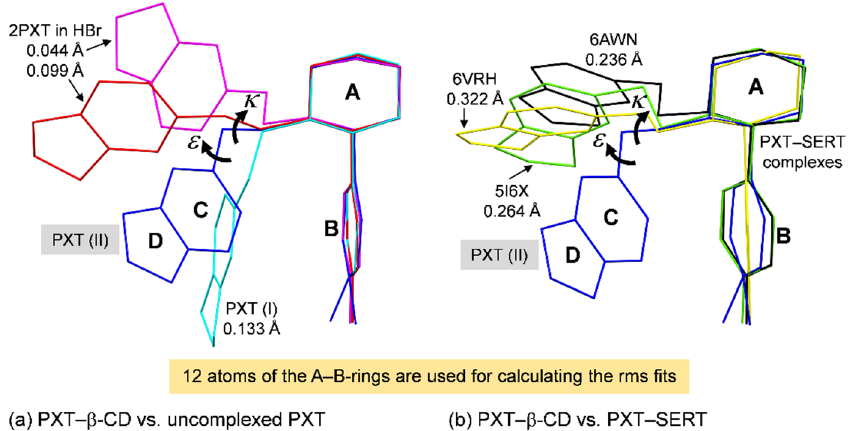
Figure 7. Structure overlays of PXT in different lattice environments, comparing PXT embedded in the β-CD cavity with ( a ) the free HBr salt form and ( b ) PXT bound to the SERT pocket. For the brief descriptions of the PXT–SERT complexes, see footnotes h–j of Table 3. PXT (II) as a reference structure is indicated by blue sticks, of which their names are marked in gray areas, and only rigid moieties of PXT [N1–C6 & C18–C23] are used for calculating the rms fits (see atom numbering in Scheme 1). The corresponding rms fit for each structure pair is indicated by a nearby distance. Torsion angles κ , ε responsible for the PXT conformational flexibility are marked.